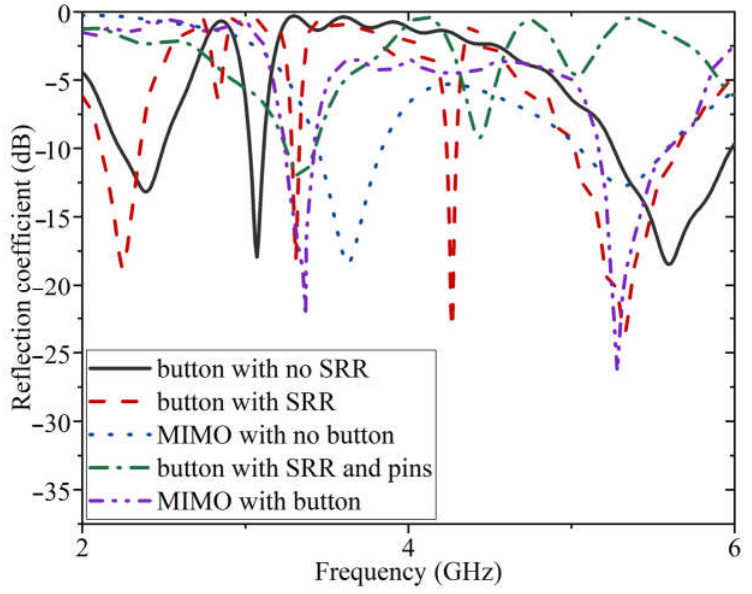
Figure 7. The reflection coefficient results of the antenna at each stage, before and after integration.